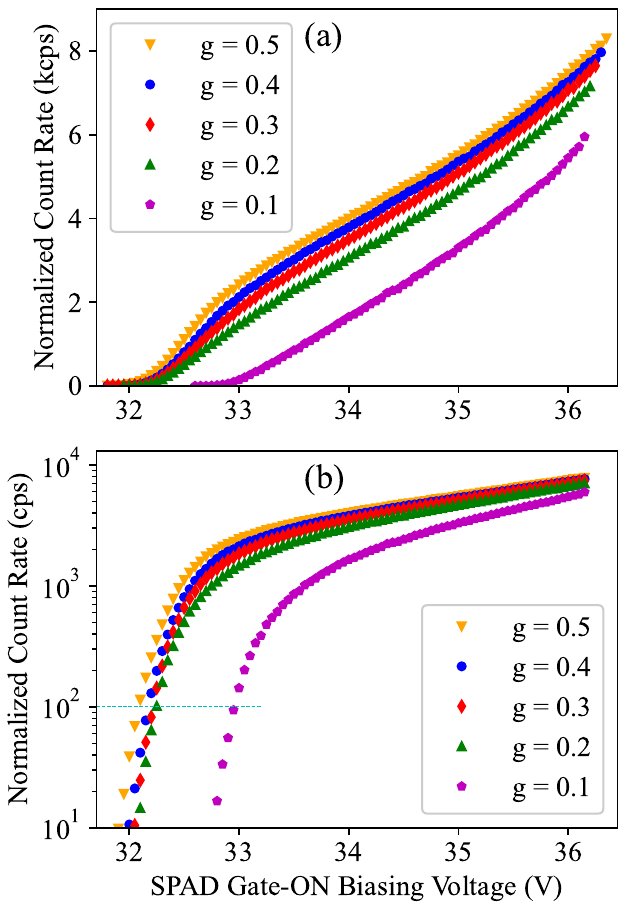
Figure 4. Dark-count rate as a function of the SPAD gate-ON biasing voltage ( | V sub | + 3.3 V) and at different duty cycle ( g ) values plotted in linear ( a ) and logarithmic ( b )